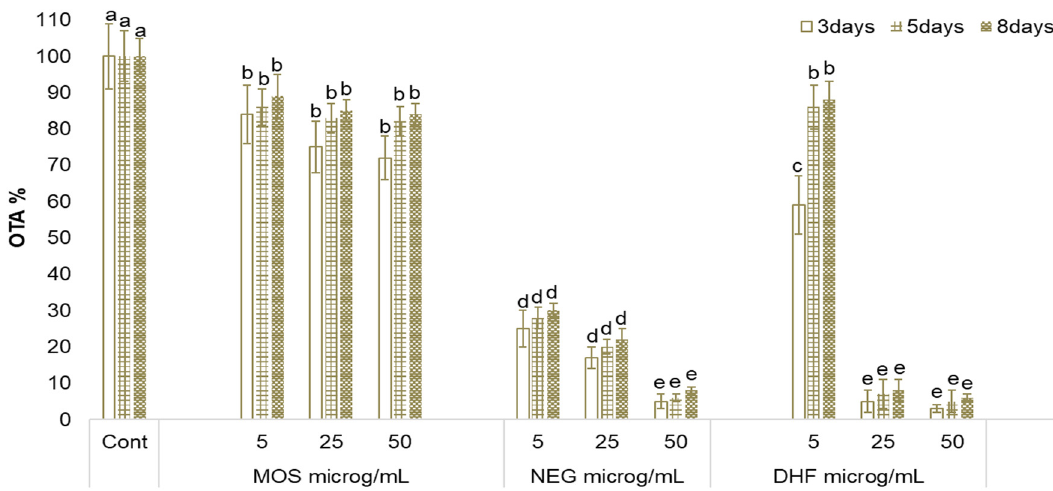
Figure 2. Effect of the addition of mosloflavone (MOS,) negletein (NEG), and 5,6-dihydroxy-flavone (DHF) on ochratoxin A (OTA) biosynthesis by A. carbonarius cultured at 25 °C in CDY 0.5% medium. The amount of OTA in the cultural filtrate of the untreated cultures (Cont) was 7, 98, and 209 ng/mL after 3, 5, and 8 days respectively. Means marked by the same letter are not significantly different (Fisher’s Protected LSD Test, p ≤ 0.05 ).